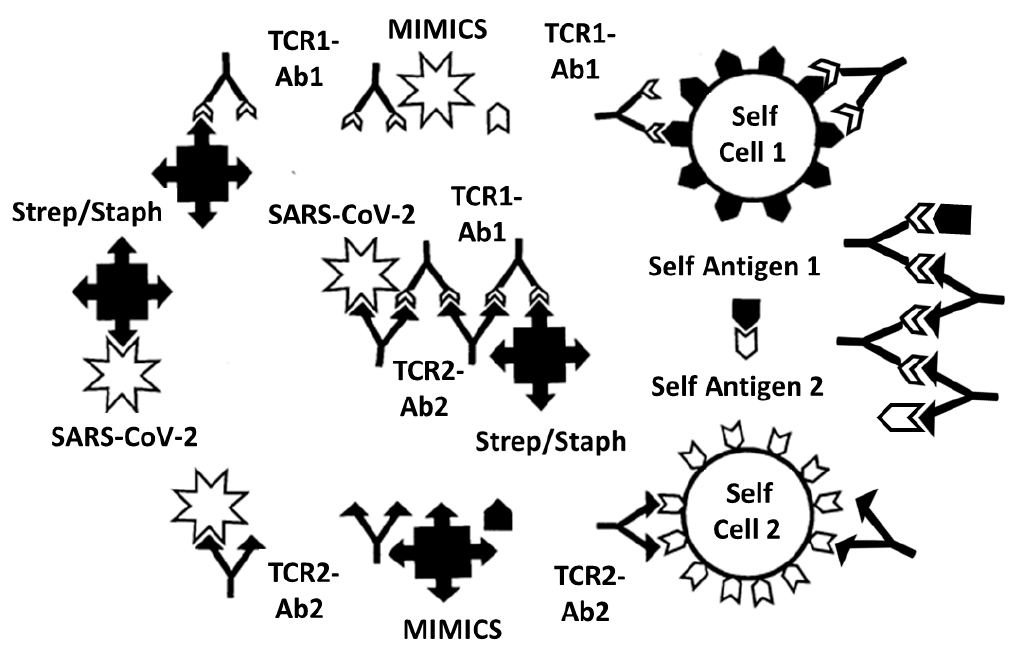
Figure 13. Schematic diagram summarizing the complementary antigen theory of autoimmune disease [119–131]. The theory proposes that autoimmune diseases are induced by pairs of infectious agents that express complementary antigens, in the case of COVID-19, SARS-CoV-2 and one of several specific bacteria such as Streptococci (Strep), Staphylococci (Staph), or Enterococci . Each microbe induces an idiotypic immune response (TCR or antibody—antibodies are shown here for simplicity) that is complementary to its antigen. Because the inducing antigens are themselves complementary, the resulting TCRs and/or antibodies will also be complementary, having an idiotype–anti-idiotype relationship (as in the anti-idiotype theory), but each produced in this case as an idiotypic response. As a consequence, each TCR/antibody will mimic one of the inducing antigens and, because each antigen mimics a host autoantigen, will also mimic a host antigen. The result will be the induction of TCRs/antibodies that bind to each other as well as to their respective microbes and to the host autoantigens that those microbes mimic. These relationships are exactly what is observed in the results reported here.